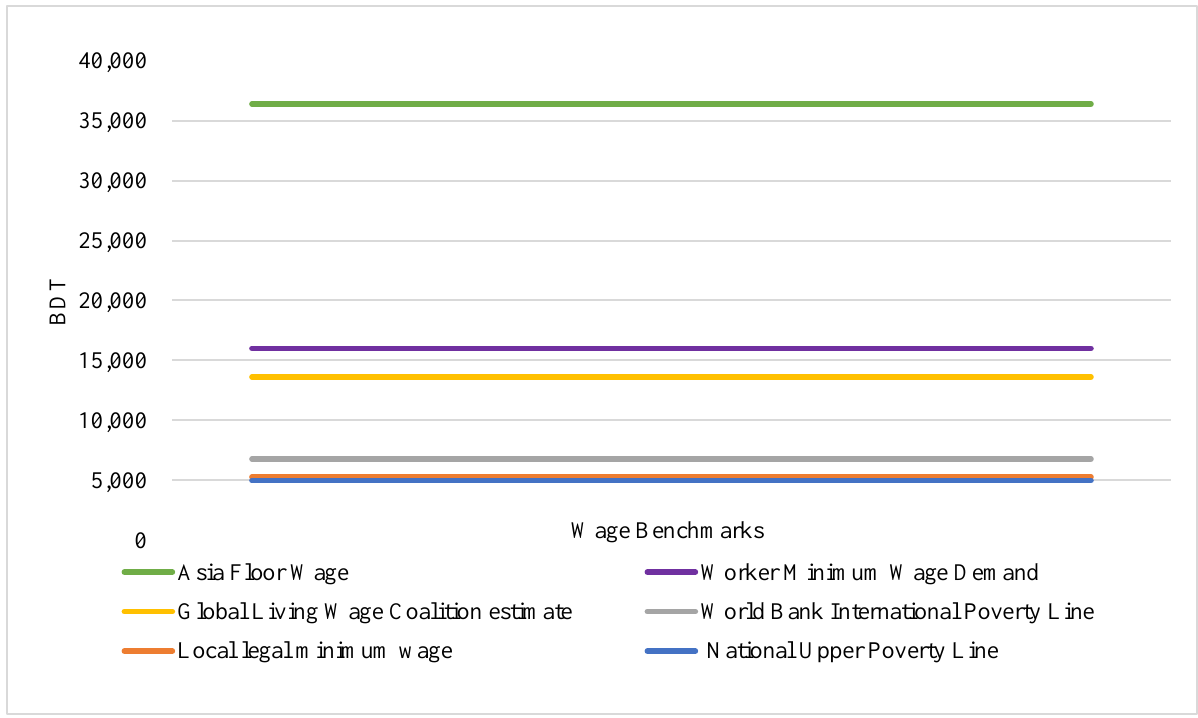
Figure 1. The variance between monthly wage benchmarks in Bangladesh, 2015 to 2017 (FLA